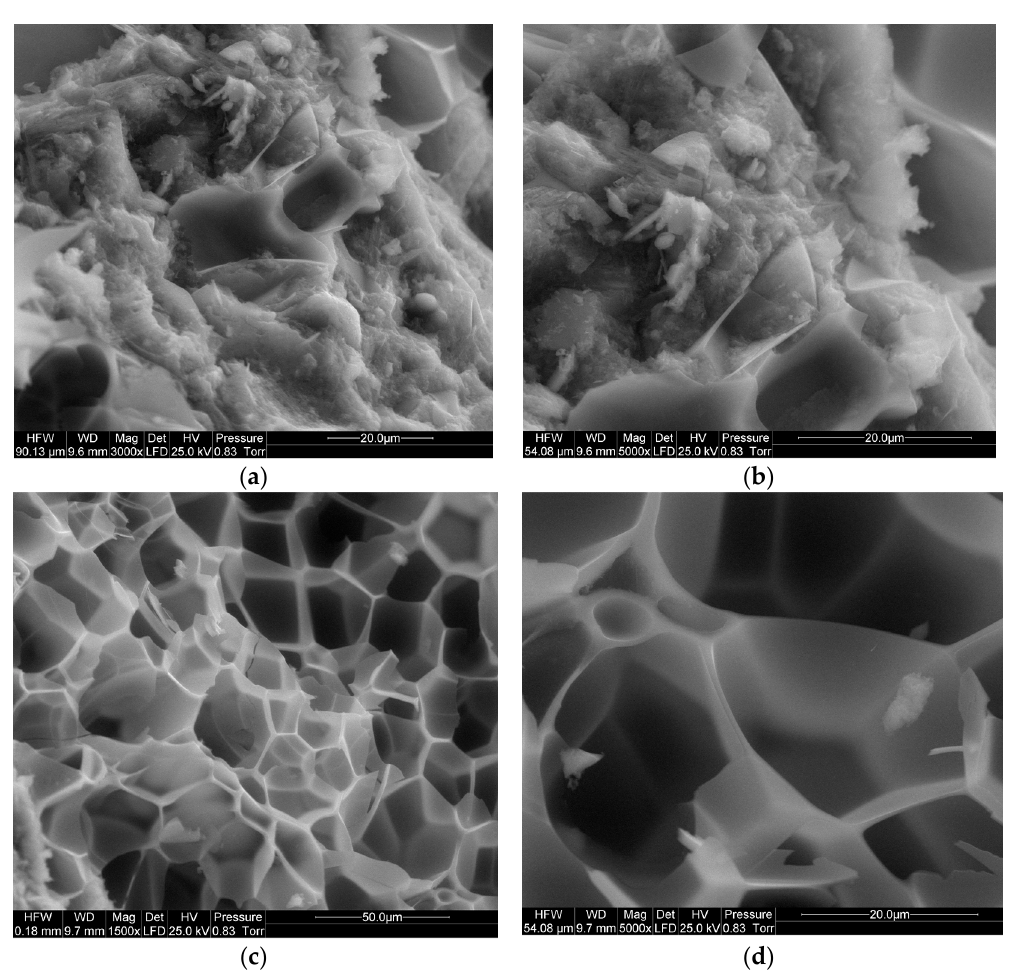
Figure 9. Microstructure of polymer-cement paste containing waste perlite powder; content values of the additions (in relation to cement mass): perlite 15%, polymer 20%. ( a ) polymer-cement interpenetrating network; ( b ) closer look to polymer-cement network; ( c ) polymer network; ( d ) detail of polymer network with embedded particles of perlite powder.